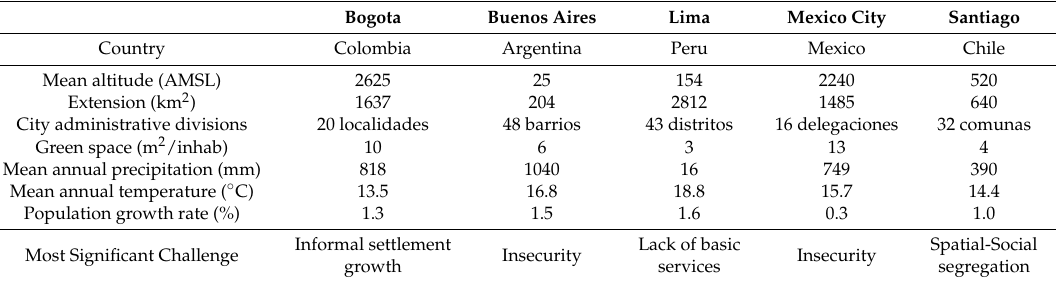
Table 1. Selected Latin American megacities and respective relevant information.